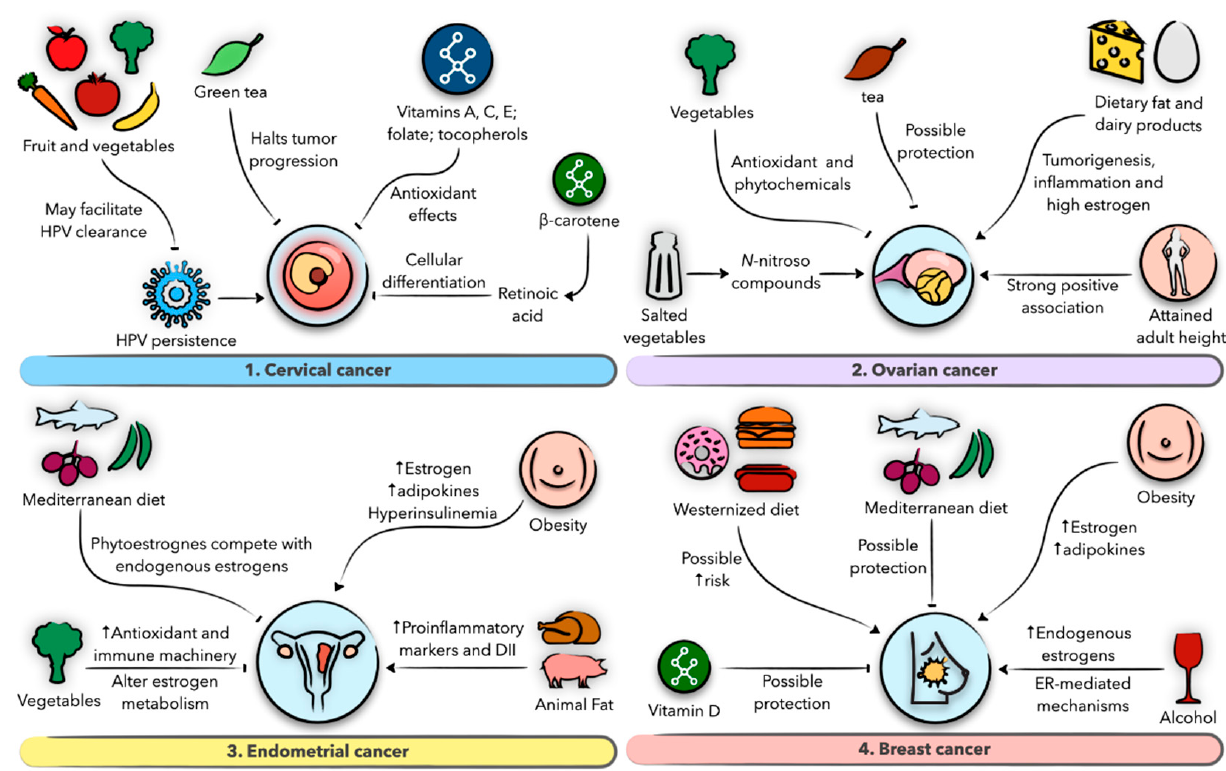
Figure 4. Schematic presentation of the role of diet and nutrition in gynecologic malignancies and the possible underlying biological mechanisms. ( 1 ) Role of diet in cervical cancer. ( 2 ) Role of diet in ovarian cancer. ( 3 ) Role of diet in endometrial cancer. ( 4 ) Role of diet in breast cancer.